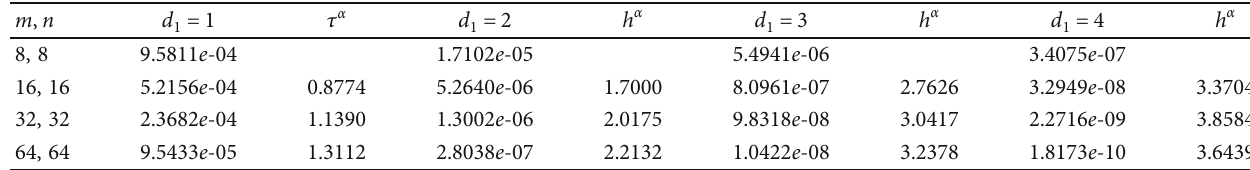
= 7 at t = 1 for equidistant nodes. 2